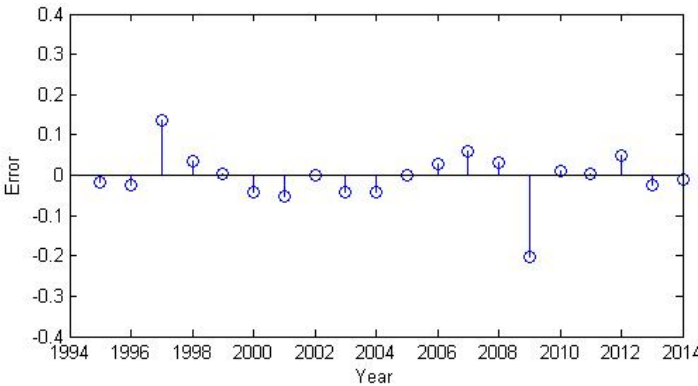
Figure 7. The prediction error of BA ‐ LSSVM.